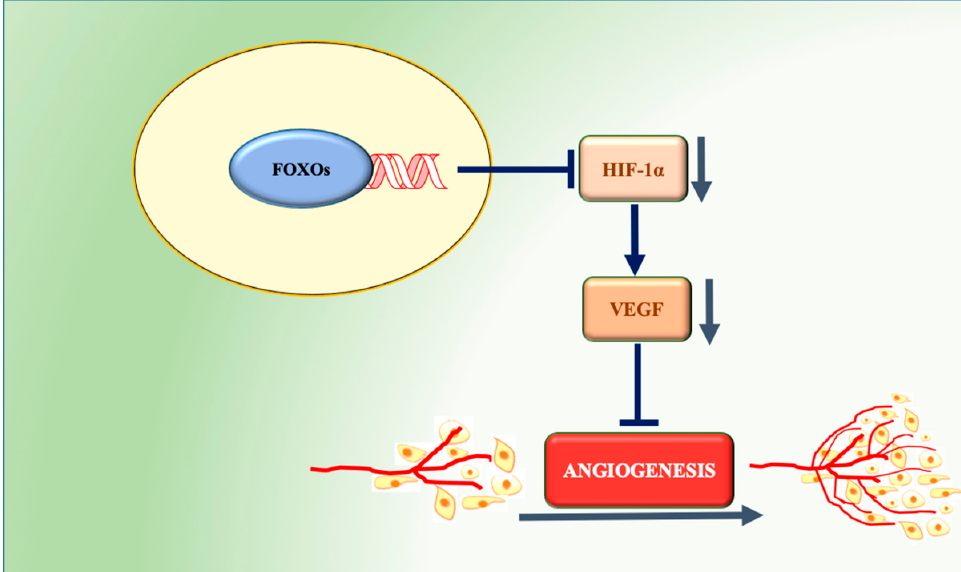
Figure 3. FOXO regulation of angiogenesis in tumor tissues. FOXOs decrease HIF-1 α protein levels and suppress the hypoxia-induced transcriptional activation of VEGF, thus inhibiting